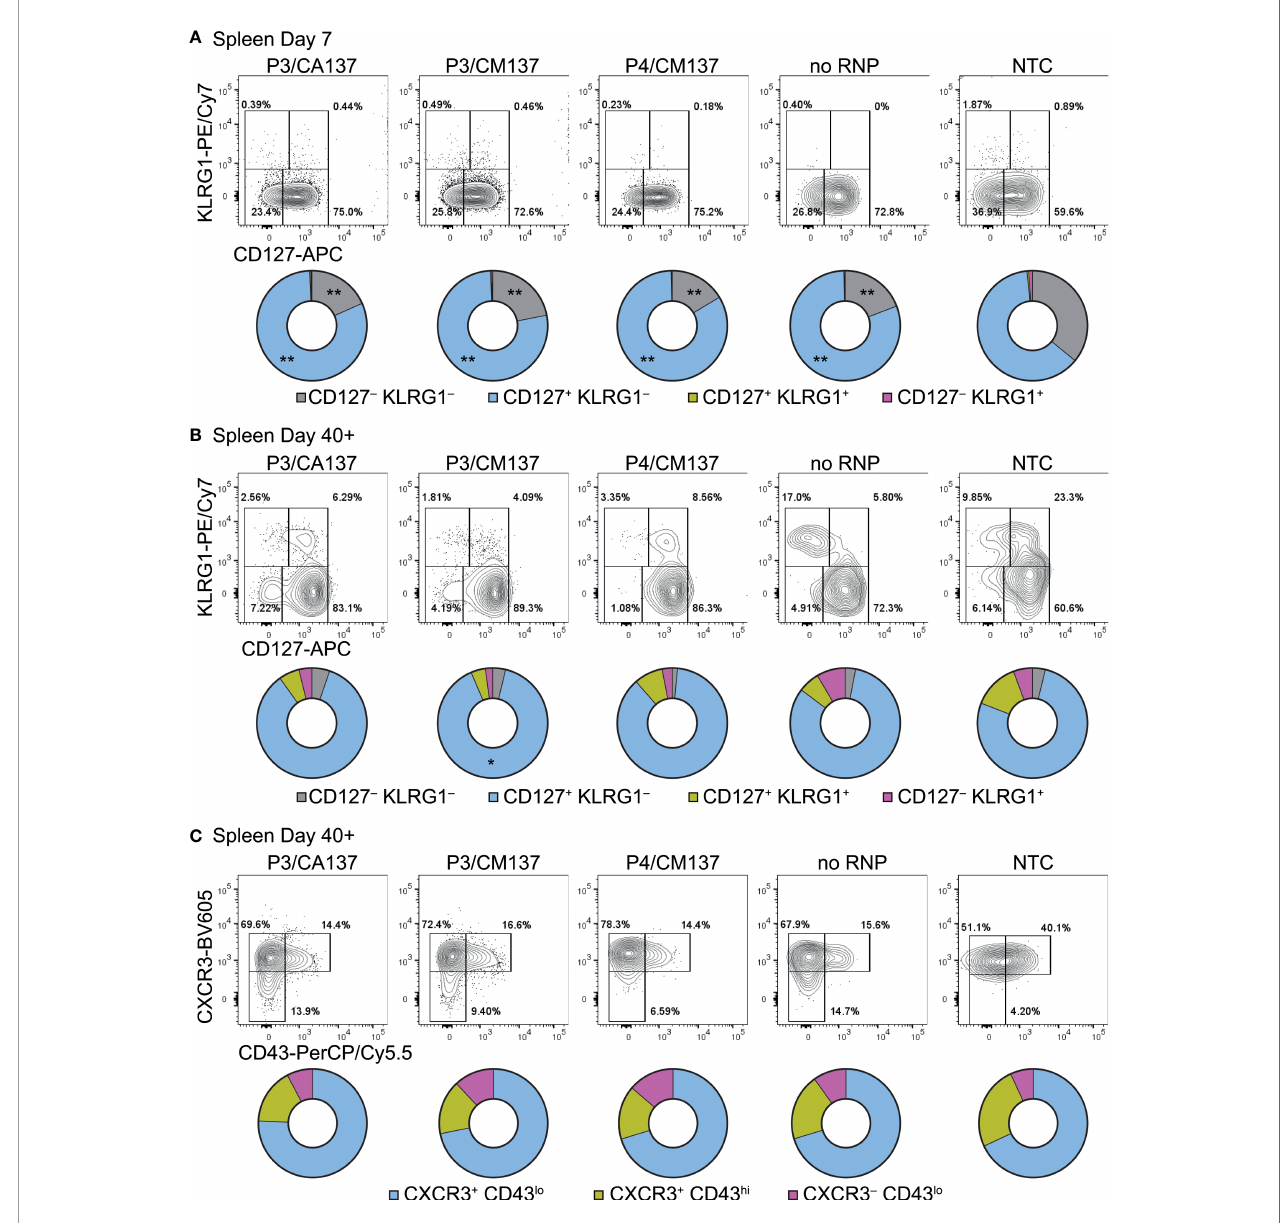
FIGURE 3 | Phenotype of in vitro -activated OT-I cells in spleen after adoptive transfer into HSV-OVA-infected hosts. OT-I cells were nucleofected as in Figure 2 . (A, B) Expression of CD127 and KLRG1 on OT-I cells in the spleen on days 7 (A) and > 40 (B) . Pie charts show the mean frequencies of four populations identi fi ed by these two markers. (C) Expression of activation-associated glycoform of CD43 and CXCR3 on OT-I cells in the spleen > 40 days after infection. Pie charts show the mean frequencies of three populations identi fi ed by these two markers. Graphs show pooled data from two independent experiments with n = 9 or 15 for each nucleofected group or non-nucleofected control, respectively. Flow cytometric plots are gated on viable OT-I cells identi fi ed by the expression of congenic markers and show concatenated data from one of two experiments with n = 5 per group. Congenic marker assignment was swapped in each experiment. * p < 0.005, ** p < 0.0001 as compared to NTC by ordinary two-way ANOVA with Dunnett ’ s multiple